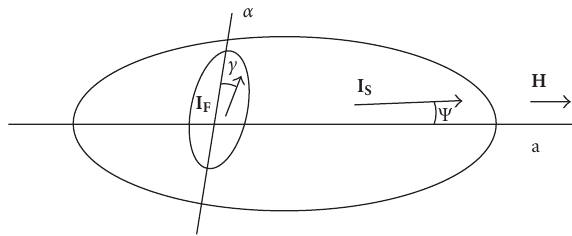
Figure 1: Core-shell magnetic structure. The larger ellipsoid has a homogeneous magnetization I S , and the smaller ellipsoid has a homogeneous magnetization I F − I S . There is a total magnetization I F − I S + I S = I F in the volume where smaller ellipsoid (core) is present in the larger one. The angle of the magnetization of the shell volume with the direction of the main axis is ψ , and the angle of the magnetization of the core with the direction of the main axis is γ